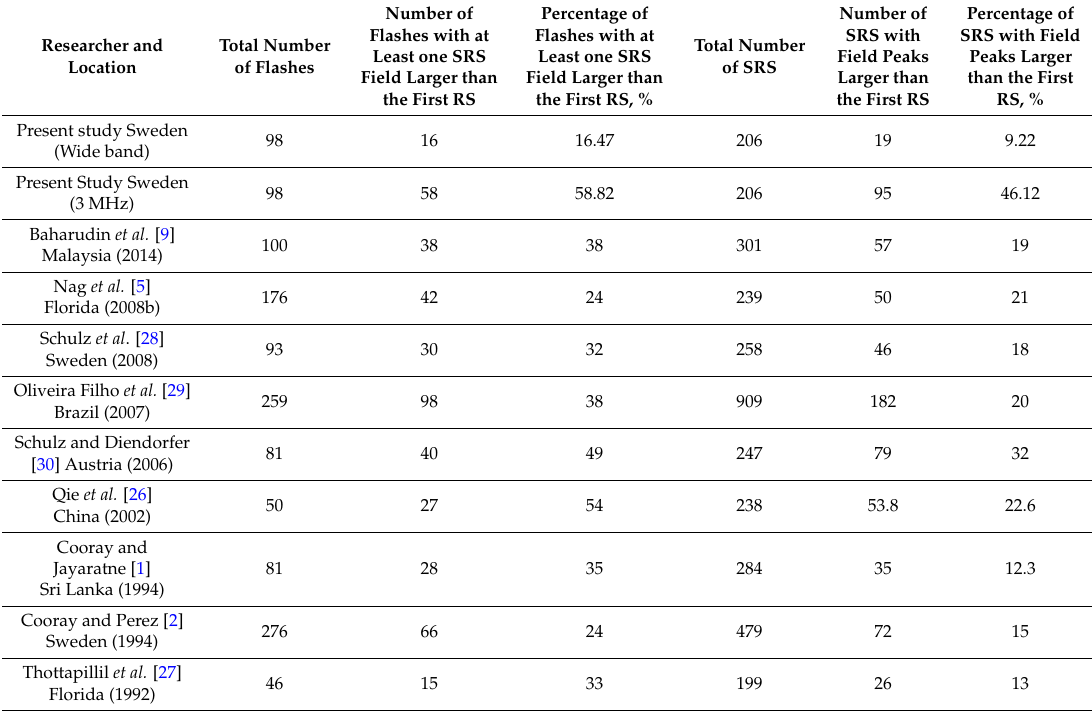
Table 8. Percentage of flashes with higher SRS peaks and percentage of SRS with higher peaks than the first